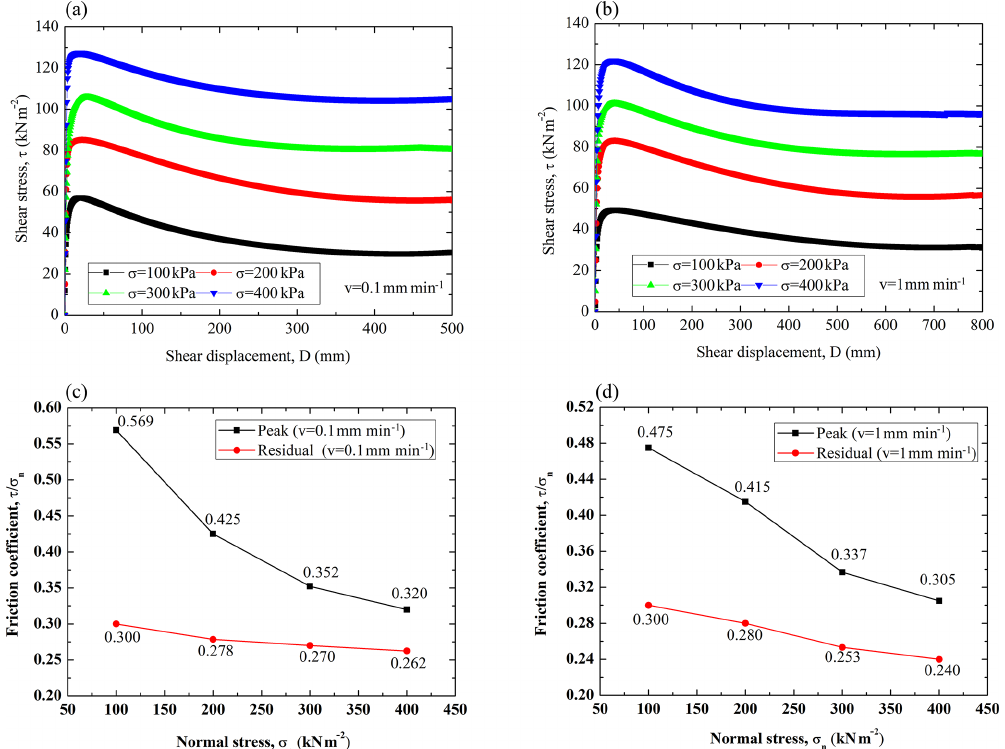
Figure 4. Shear behavior characteristics of DJG soil samples. (a) Relationship between shear stress and shear displacement. (b) Relationship between friction coefficient and normal